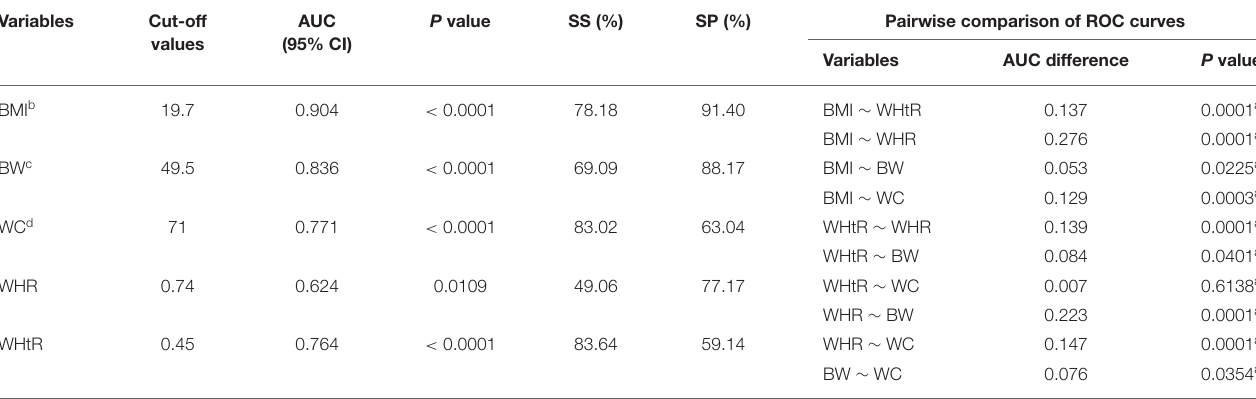
Variables AUC difference P value